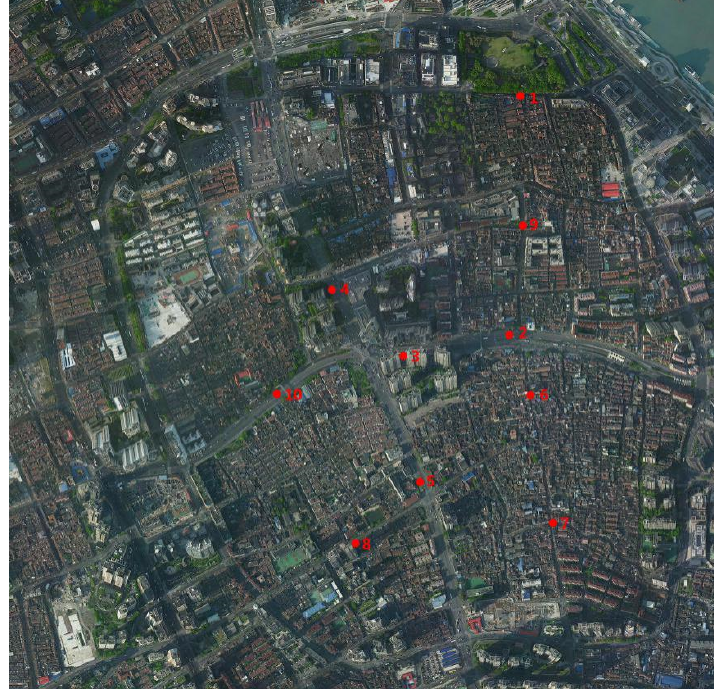
Figure 3. Monitoring points for field measurements in the old downtown zone values and simulated values.